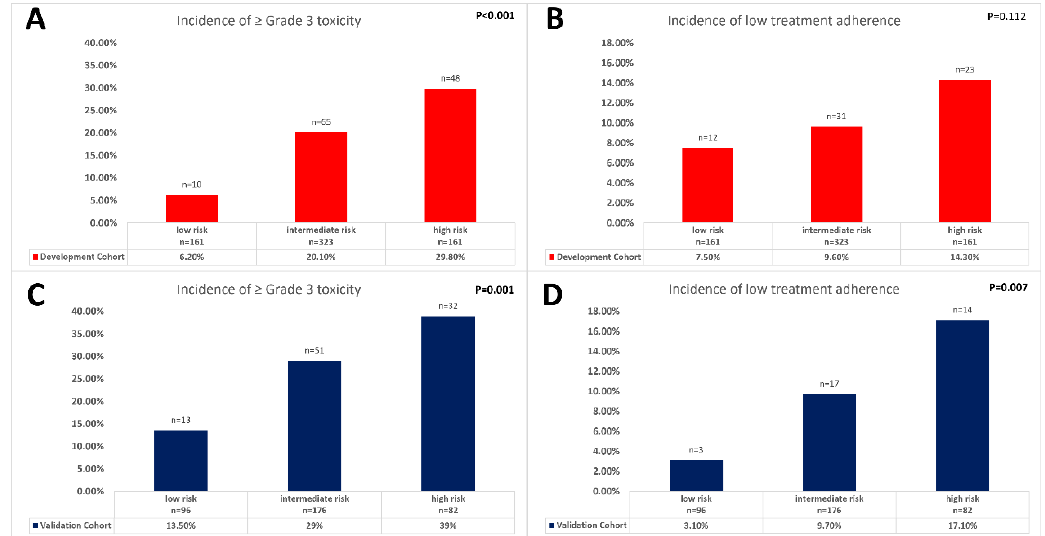
Figure 2. Distribution of toxicity and low treatment adherence within the three risk groups in ( A , C )